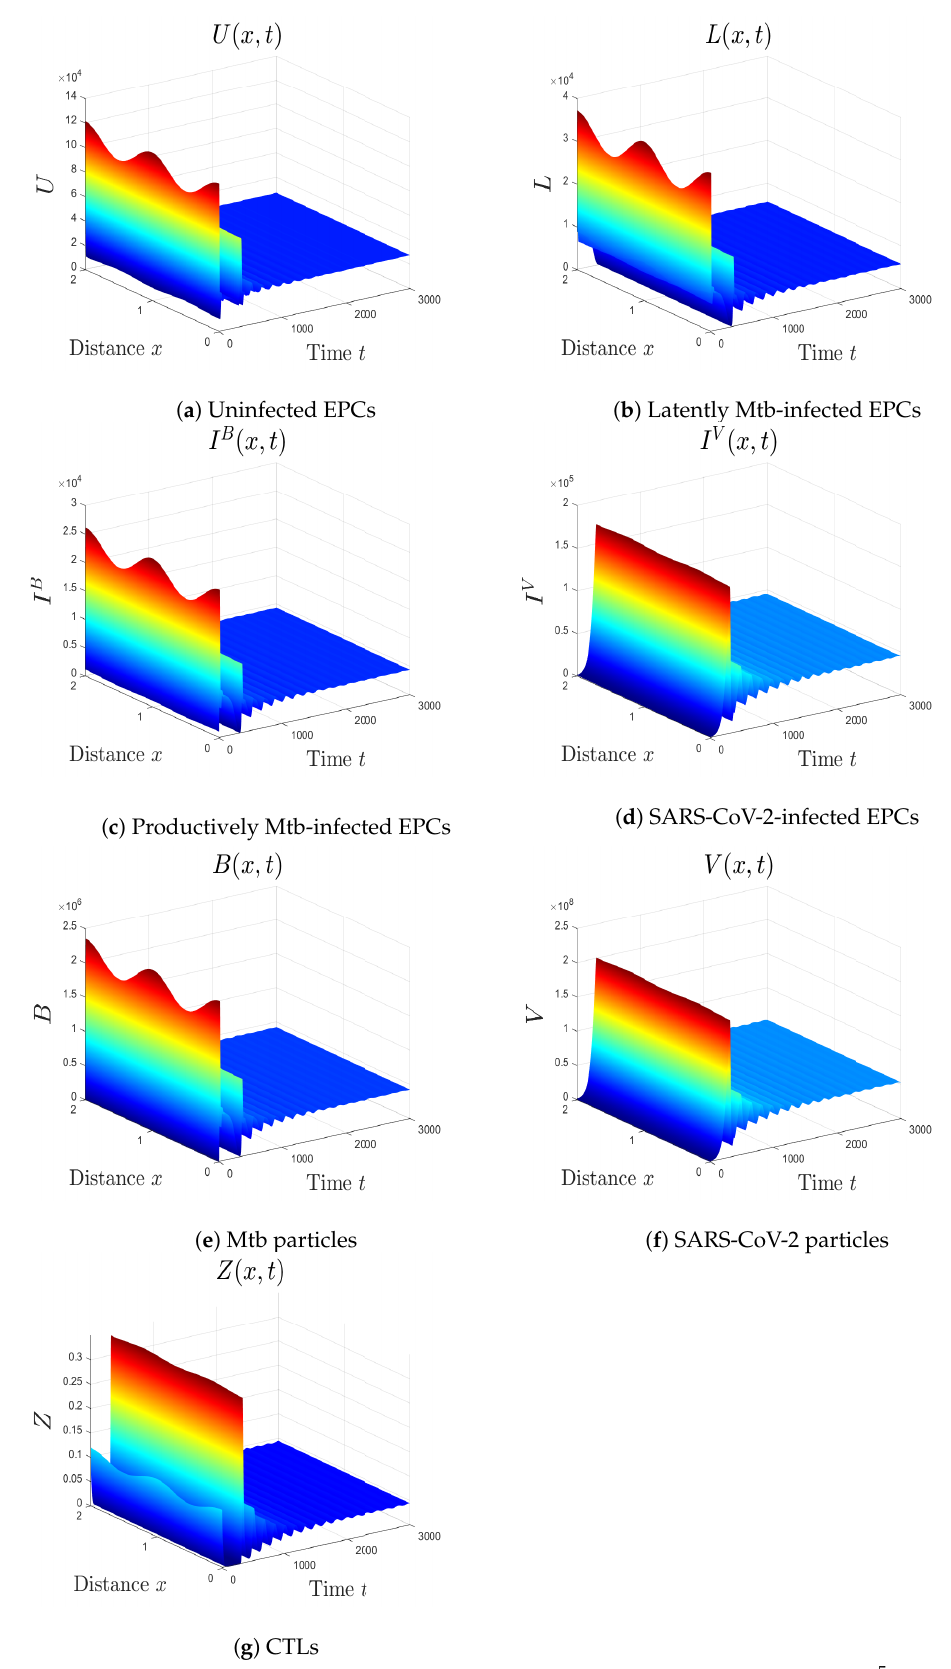
Figure 7. The impact of changing the diffusion coefficients in case (vi) to 1 × 10 − 5 . The initial distributions of the solutions are affected, while the global stability is not